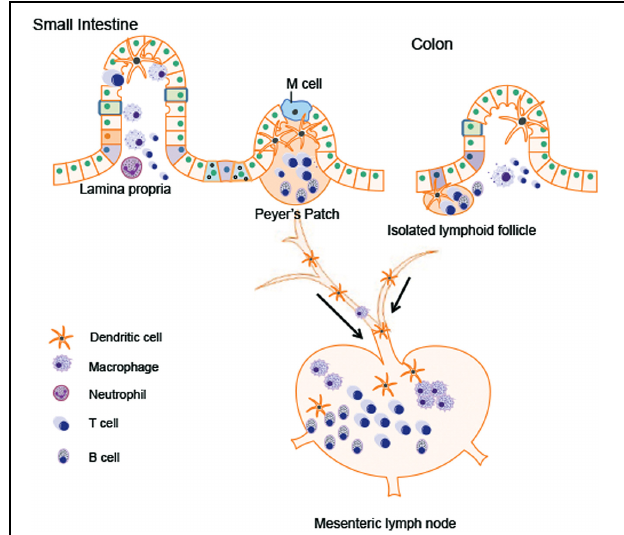
FIGURE 2 | Immune cells in gastrointestinal (GI) tract. The major immune cell population within gut tissues includes macrophages, dendritic cells, neutrophilic granulocyte, T lymphocytes, and B lymphocytes. The Peyer’s patches in the small intestine and the isolated lymphoid follicle in the colon are composed of dendritic cells, B cells and T cells, which are crucial for antigen presentation from gut lumen. Antigen presenting cells (APCs) migrate to the mesenteric lymph node (MLN) through afferent lymphatic system. By receiving the signals presented by APCs, MLN amplify the immune responses. Lamina propria T cells have the characteristics of activated effector lymphocytes. The major populations of T cells residing in lamina propria are the CD4 + T cells, predominated by Th1 and Th17